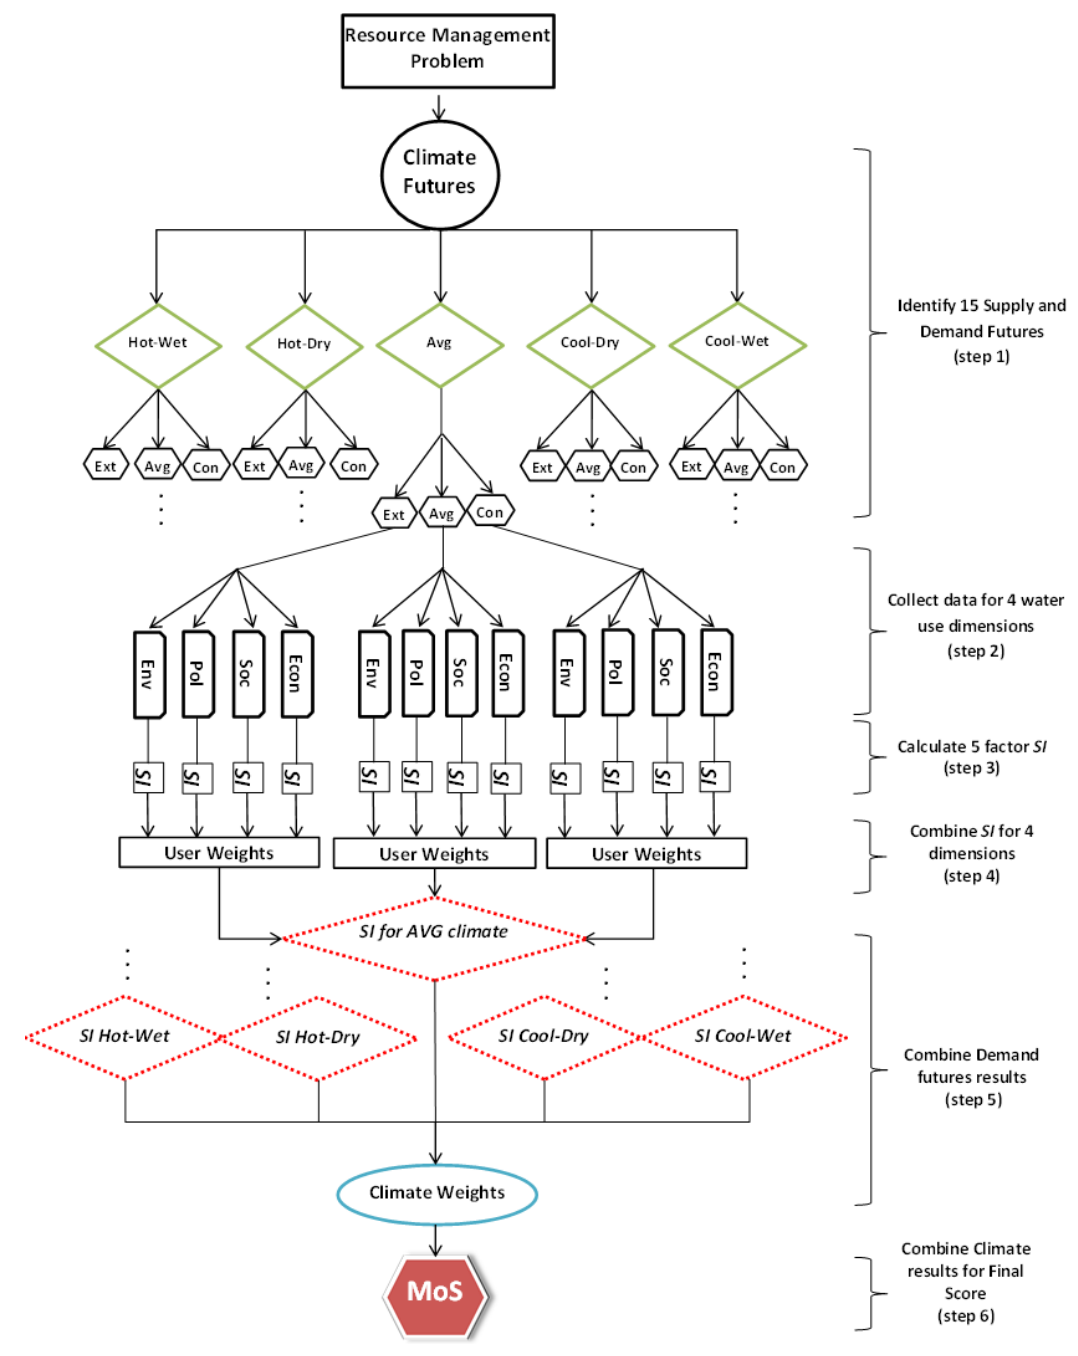
Figure 3. Flow chart of Steps 1–5 of MoS methodology for Avg. climate scenario. Step 6 combines all climate scenarios using weights from ∆(cid:1846) (cid:1874)(cid:1871). ∆(cid:1842) plot for final MoS score. Step numbers correspond to the list of steps outlined